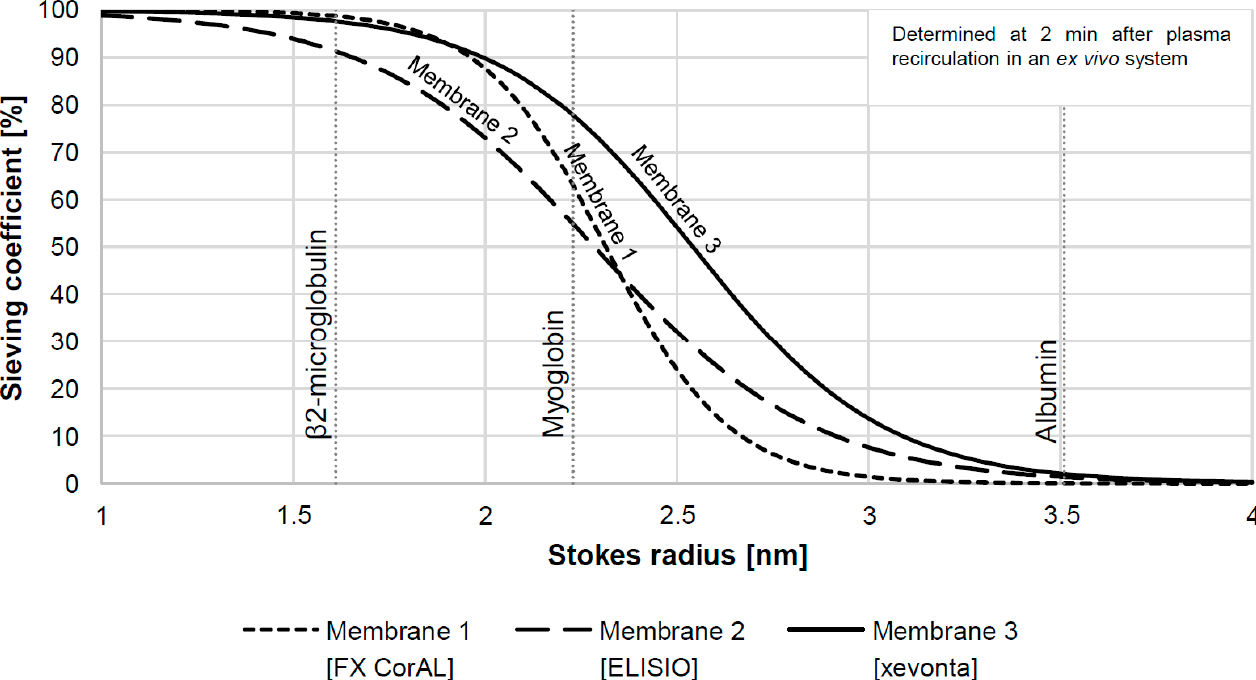
Figure 1. Schematic illustration of sieving coefficients as a function of Stokes radius for three different dialysis membranes. The sieving profiles were determined 2 min after plasma recirculation in an ex vivo system and differ in terms of retention properties across the range of solutes up to the size of albumin. Data were reanalyzed from recently published data [24] (n = 3 for each membrane; membrane 1: FX CorAL [Fresenius Medical Care]; membrane 2: ELISIO [Nipro]; membrane 3: xevonta [B. Braun]).